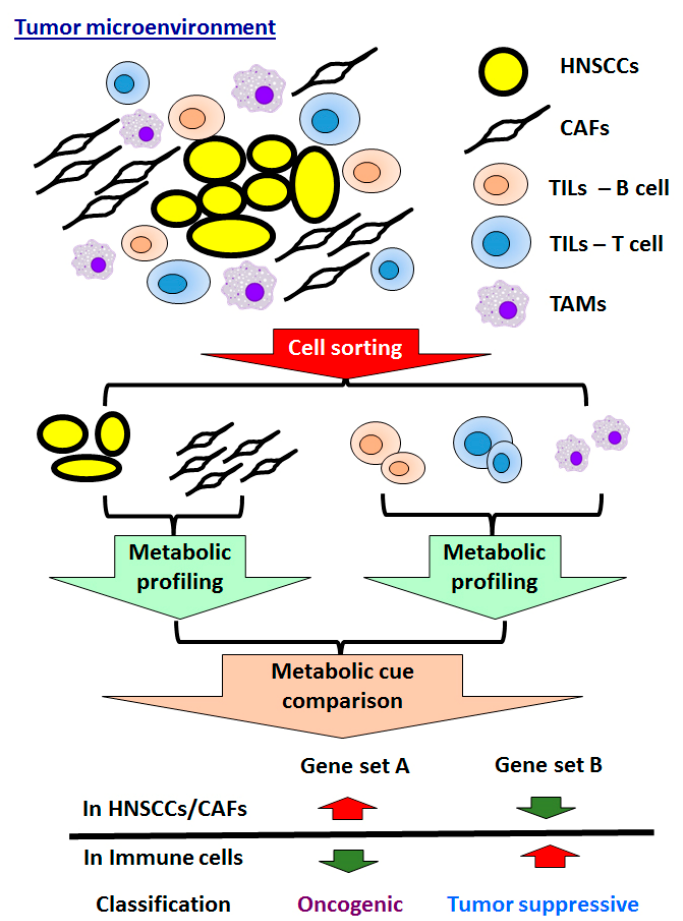
Figure 2. Exploring TME-associated tumor activators/inhibitors in HNSCCs. A comparison between the metabolic profiles of sorted tumor cells, CAFs and tumor-associated immune cells could define oncogenic or tumor suppressive metabolic molecules. The reciprocal expression between HNSCCs/CAFs and tumor-associated immune cells could be molecules of interest. CAFs: Cancer associated fibroblasts; TILs: Tumor infiltrating lymphocytes; and TAMs: Tumor associated macrophages.